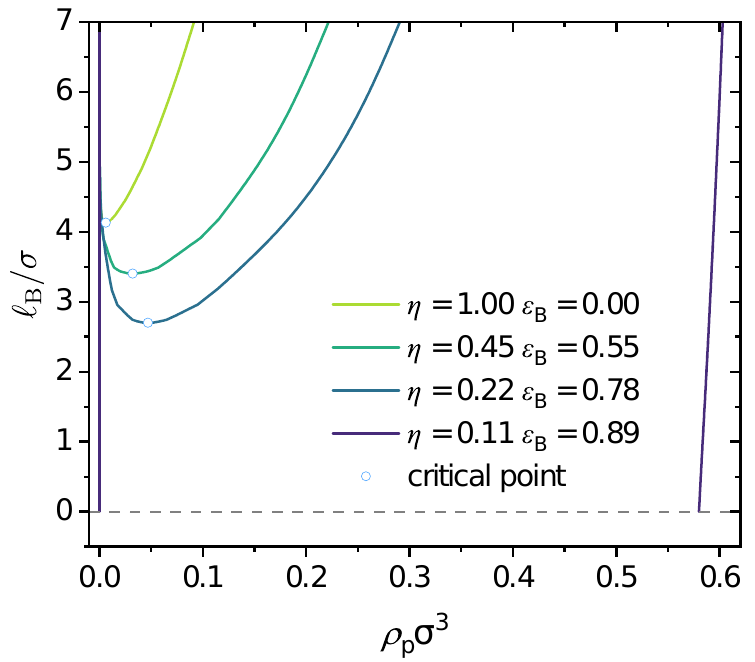
Figure 11. Predicted binodal curves from the GUI App presented in this work. The values for the following parameters were fixed: (cid:101) A = 0, (cid:101) AC = 0, N T = 100, Z C = + 1 and Z A = − 1. Values for the charge fraction η and the interaction strength between the neutral segments of the polymer (cid:101) B were varied. As η was varied, the N 1 -parameter, N 1 = N T η − 1 (block copolymer), was varied as well. The dashed line shows the limiting value of (cid:96) B / σ = 0.